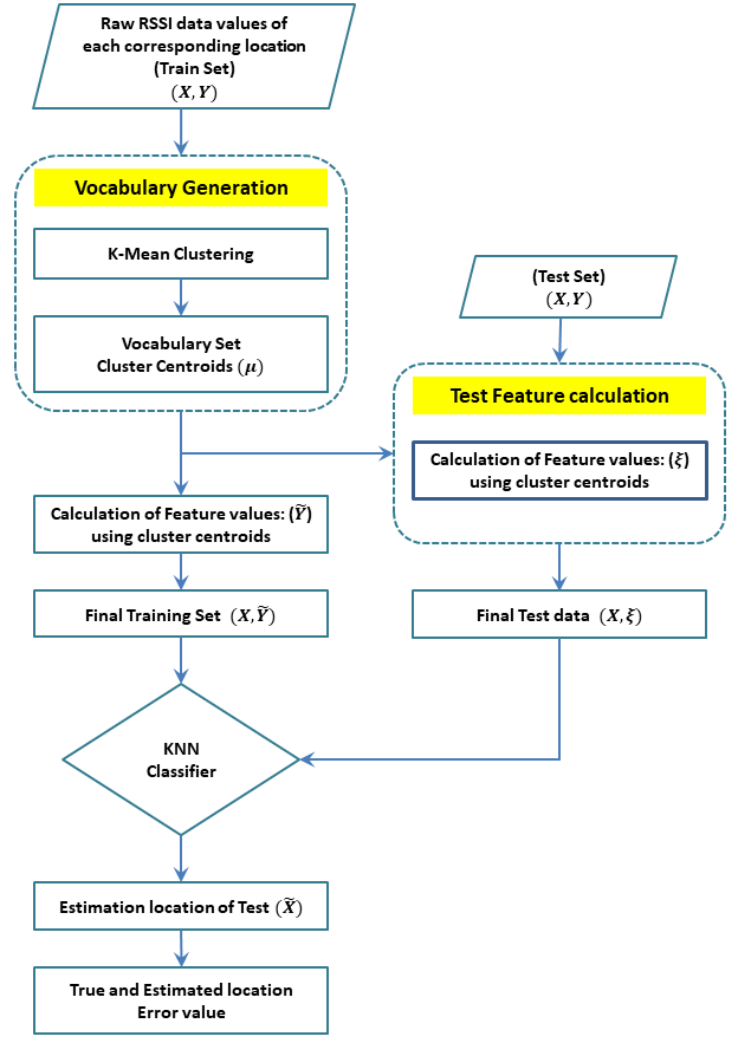
Figure 3. Step-by-step functionality of the proposed BoF-assisted approach. Algorithm 1 Syntax of the proposed BoF indoor positioning